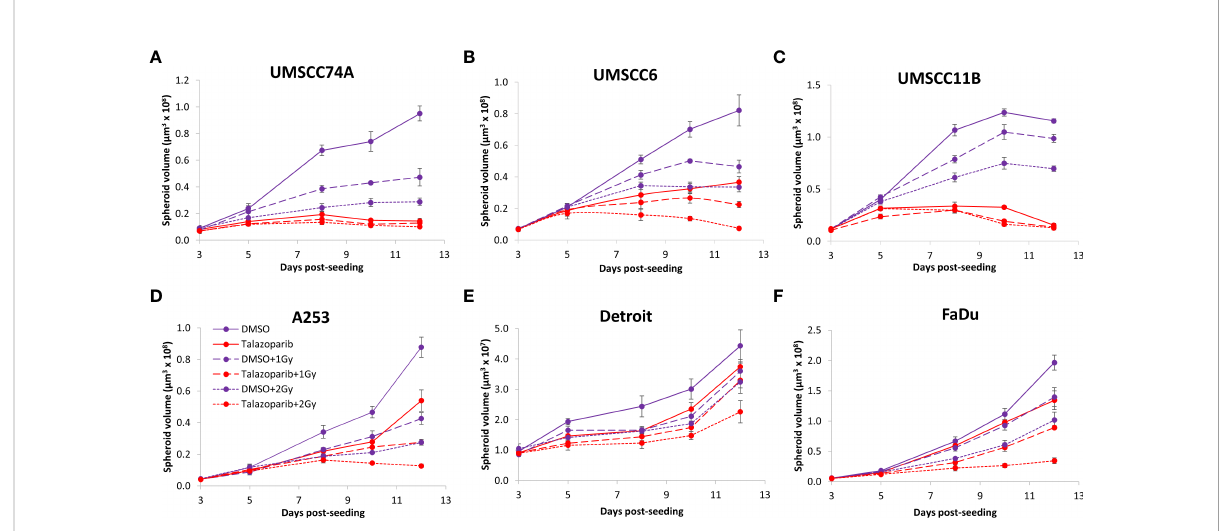
FIGURE 5 Impact of talazoparib on the radiosensitivity and growth of HPV-negative HNSCC spheroids. Spheroids were allowed to develop for 24 h in ultra-low attachment plates, treated with DMSO or talazoparib (0.1 µM) for a further 24 h, and then unirradiated or irradiated (1 or 2 Gy) on day 3 with a single dose of x-rays. Growth of spheroids derived from cells from (A, B) the oropharynx (UMSCC74A and UMSCC6), (C) the larynx (UMSCC11B), (D) the salivary gland (A253), and (E, F) the hypopharynx (Detroit 562 and FaDu) was measured by microscopy up to 12 days post- seeding and analysed from three biologically independent